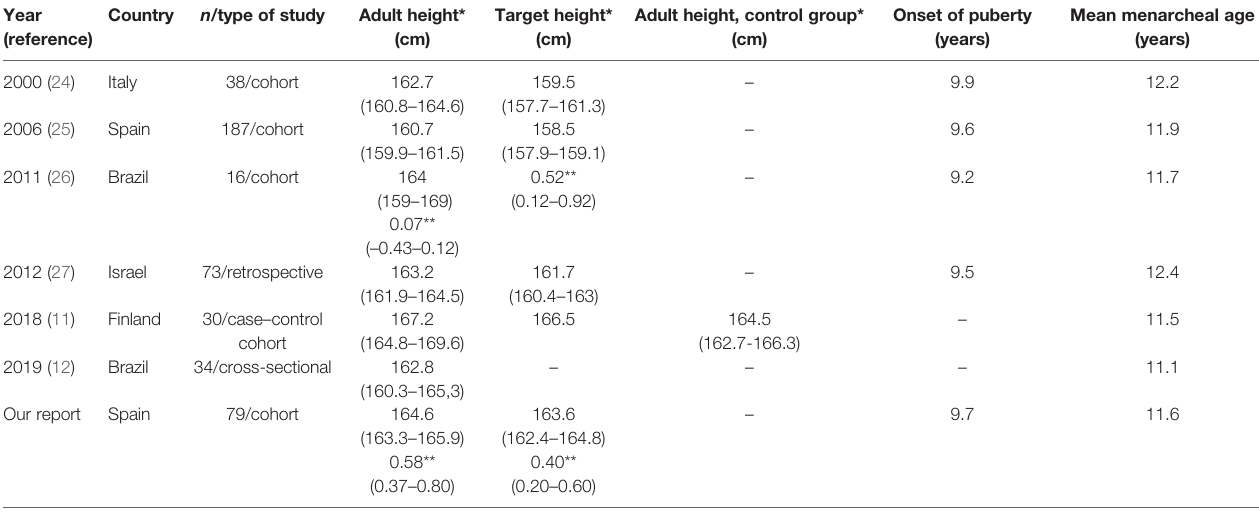
TABLE 3 | Different studies of adult height-related data in girls with a history of